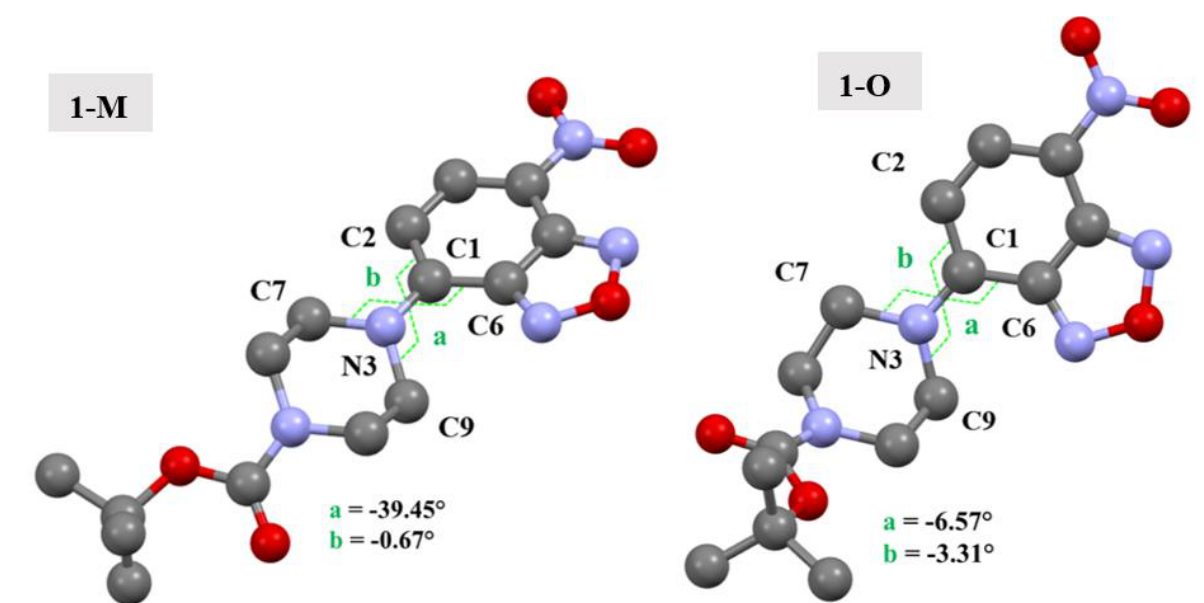
Figure 13. Molecular structures of 1-M and 1-O showing the torsion angles which show the different arrangement of the piperazine ring. Hydrogens omitted for clarity.